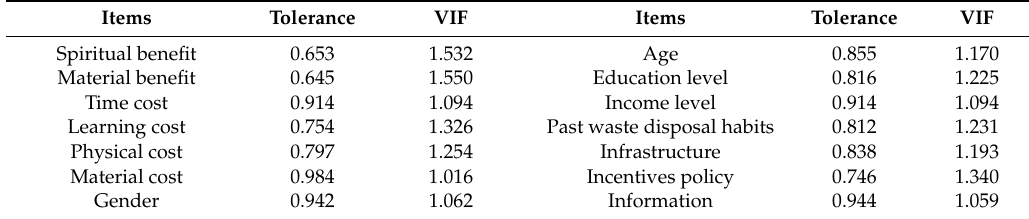
Table A1. Multi-collinearity test.